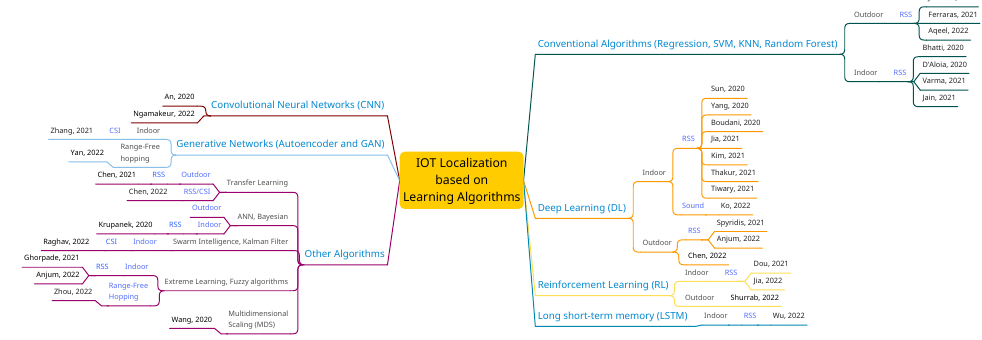
Figure 3. Classification of the reviewed literature, with emphasis on the learning algorithms